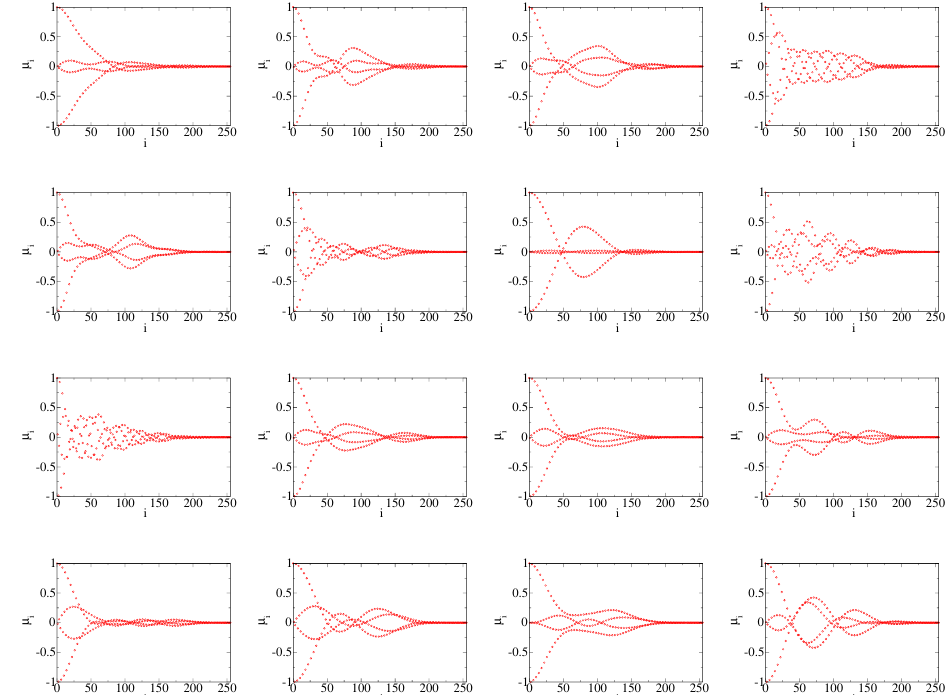
Figure 2. The coefficients of the Chebyshev polynomial expansion for 32 randomly chosen parameter sets of the finite cluster. Only the first 256 coefficients are shown, as higher order terms are vanishingly small. Only the coefficients directly calculated from the kernel polynomial method (KPM) are shown here. The coefficients obtained from the neural network match very closely with the ones from the KPM and would not be visible by laying them on the same plot, and thus they are omitted. The spectral functions and the corresponding parameters are presented in Figures 3 and 4 respectively. We demonstrate the quality of the coefficients obtained from the neural network in Figure 5. The magnitude of the the last five coefficients in each panel is smaller than 10 − 5 .